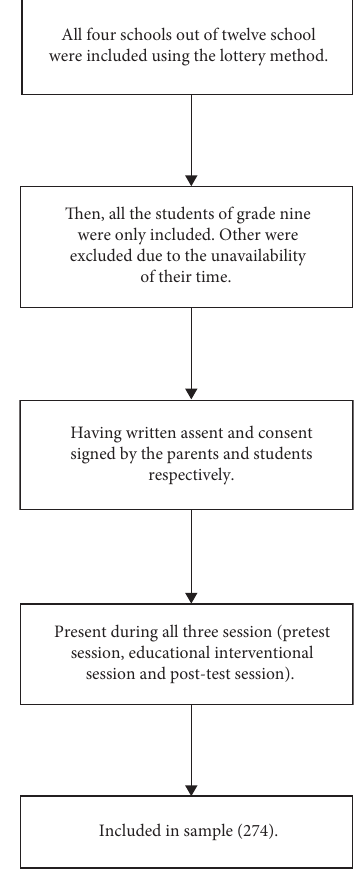
Figure 1: Flow diagram of inclusion of schools and